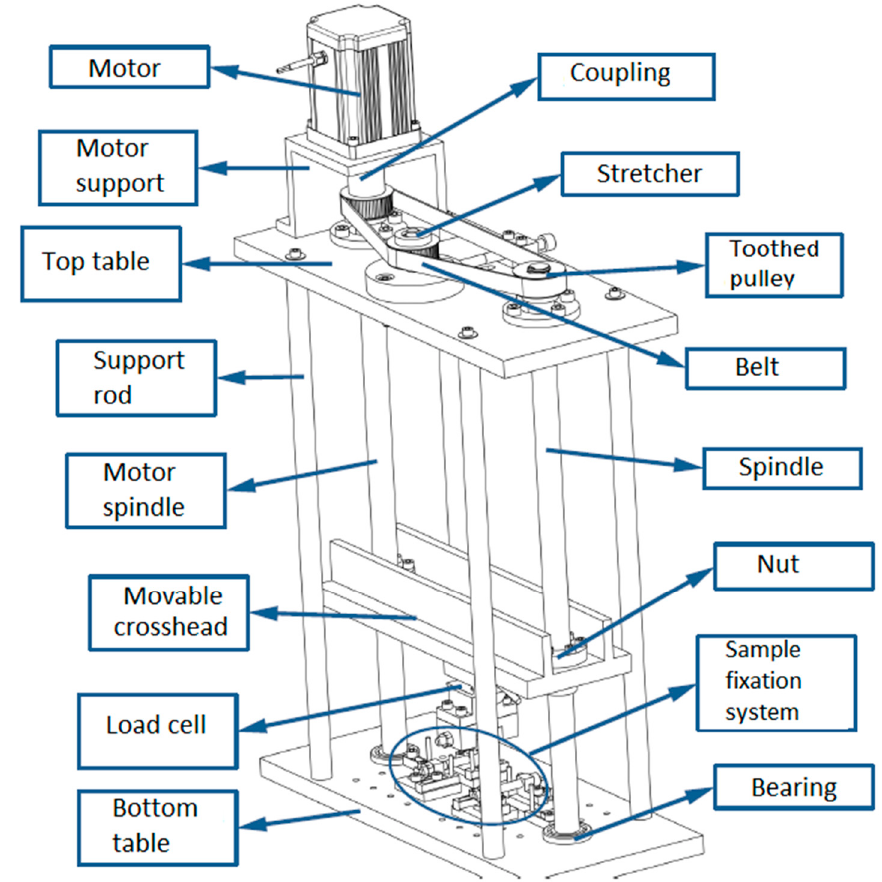
Figure 1. Illustration of the fatigue testing machine.